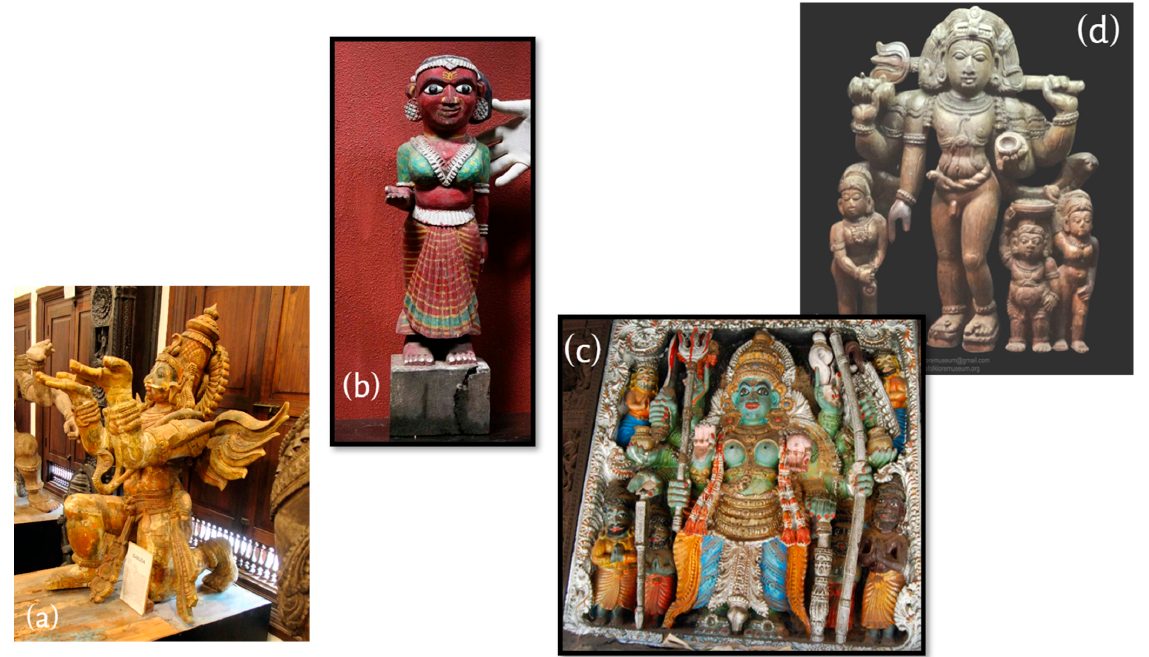
Figure 4. Wooden Hindu statues of Kerala: ( a ) Garuda, Kerala Folklore Museum, 17th/18th century; ( b ) Tribal Woman, Kerala Folklore Museum; ( c ) Durga, Polychrome relief, ca.18th century, Thrikkuratti Mahadeva Temple; ( d ) Shiva as Bhikshatana Murti (beggar), Kerala Folklore Museum.